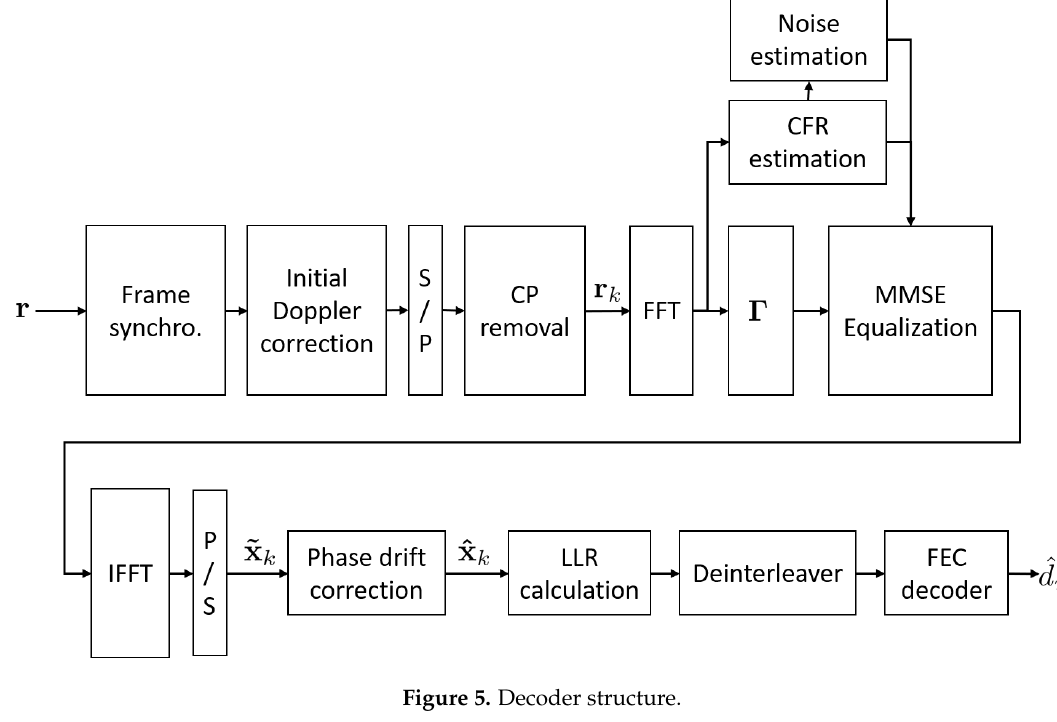
Figure 5. Decoder